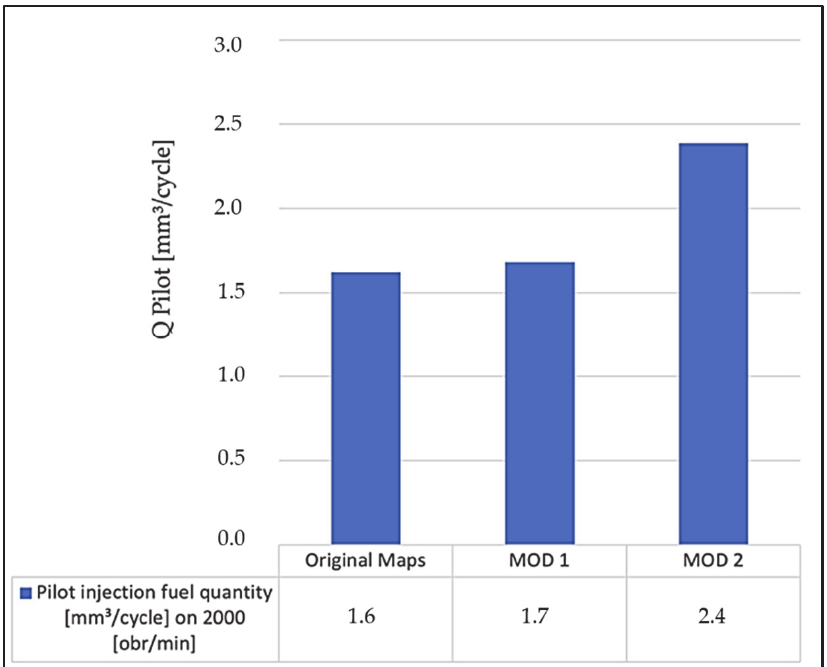
Figure 12. Pilot injection fuel quantity on 2000 RPM and 130 Nm.